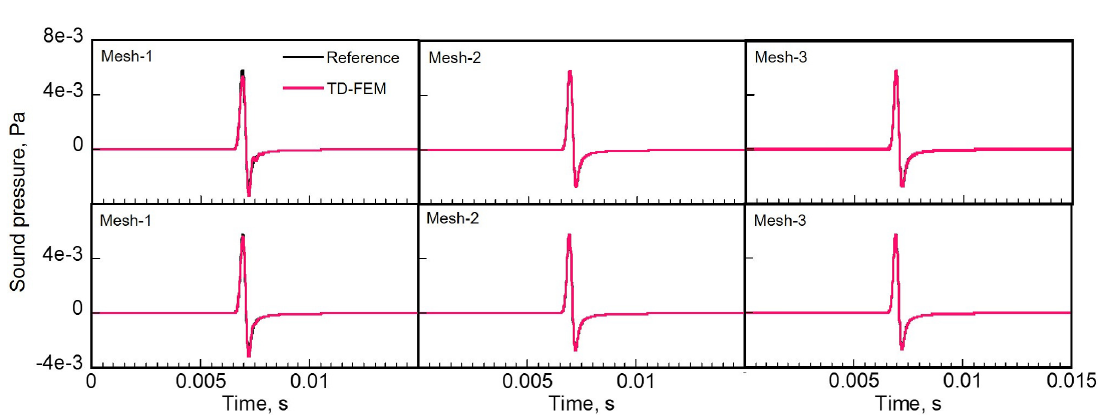
Figure 4. Waveforms at the receivers in the axial direction (upper row) and the diagonal direction (lower row) between the reference solution and the proposed method for three FE meshes (Mesh-1, -2 and -3) listed in Table